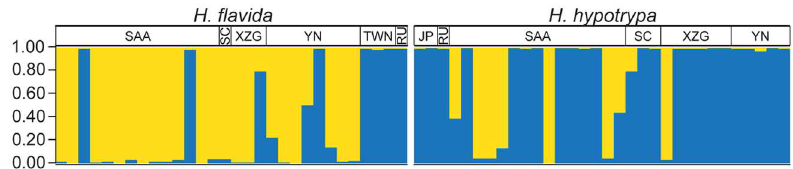
Fig 4. Results from a Bayesian genetic clustering analysis of the Hypogymnia hypotrypa group. Individualpopulationassignments were inferred using a STRUCTURE analysis of single nucleotide polymorphisms from multi-locus sequencedata from specimens identifiedas H . flavida and H . hypotrypa under a model assumingtwo genetic groups. The horizontalaxis gives specimennumbers. The vertical axis represents the inferred proportion of each individual’s genome assignedto a genetic cluster, with assignment probability into the two different genetic clusters depicted with distinct colors–’cluster 1’ shown in yellow and ’cluster 2’ in blue. Specimenswithin each taxon are clustered by geographic region (SAA = Shaanxi; YN = Yunnan;XZG = Tibet; SC = Sichuan; TWN = Taiwan; JP = Japan; and RU = Russia). Population assignments for each specimen are reported in S1